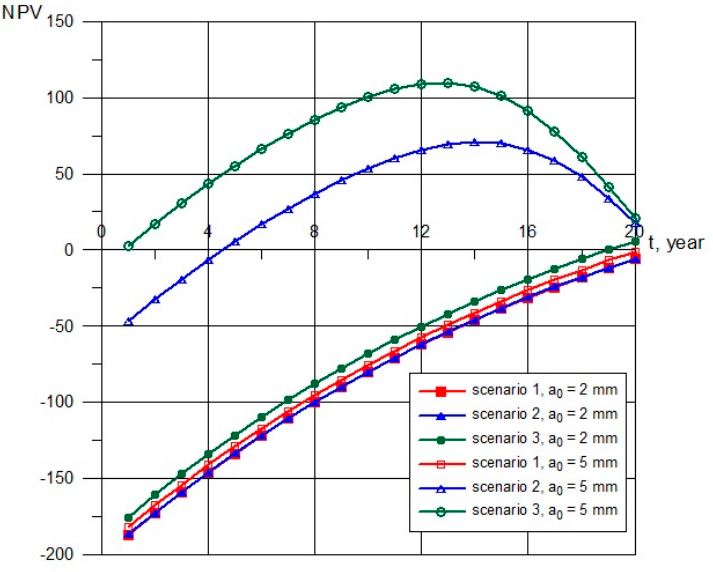
Figure 9. Change in the net present value ( NPV ) index over 20 years for different operating scenarios (for a 0 = 2 mm and a 0 = 5 (for a 0 = 2 mm and a 0 = 5 mm).